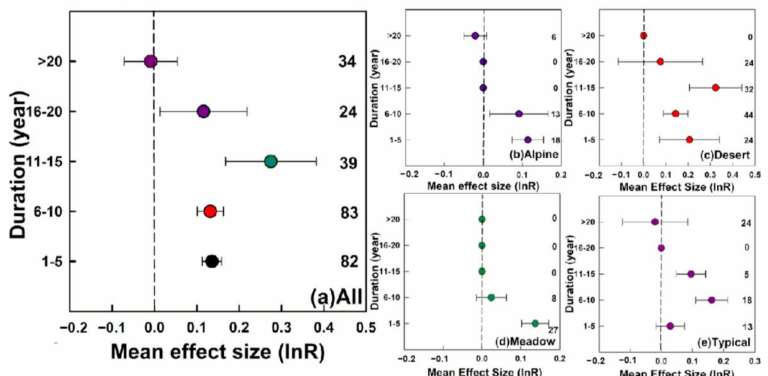
Figure 7. The effect value of plant species diversity under different enclosure years ( a ) and the response of different grassland plant species diversity to enclosure ( b – e ). The values are calculated effect sizes and 95% confidence intervals. Sample sizes are given to the